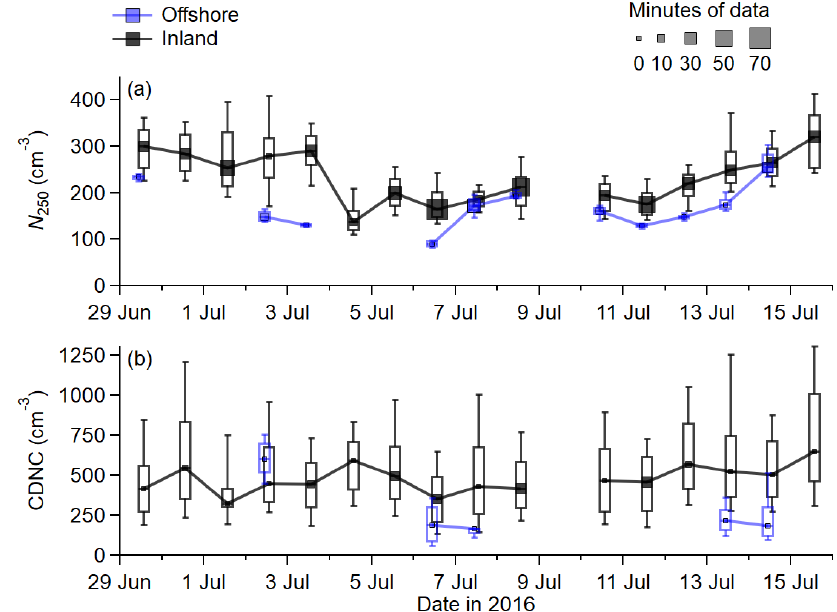
Figure 6. Day-to-day variation in N 250 (a) and CDNC (b) . The data shown are from all data measured below 1km. The markers, boxes, and bars show the medians, 25th and 75th percentiles, and the 10th and 90th percentiles respectively. Offshore data were collected over 20km south of the